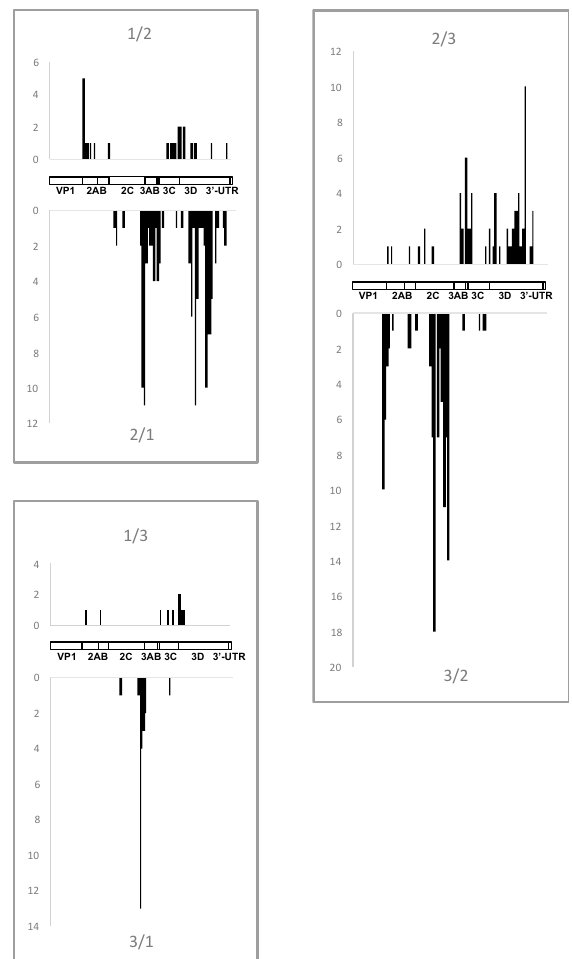
Figure 5. The location of all intertypic crossover sites in the analyzed recombinants. The number of respective crossovers is given on the vertical axes. Schematic genome maps are also presented. In this and the following Figure the data from [12] are also included.